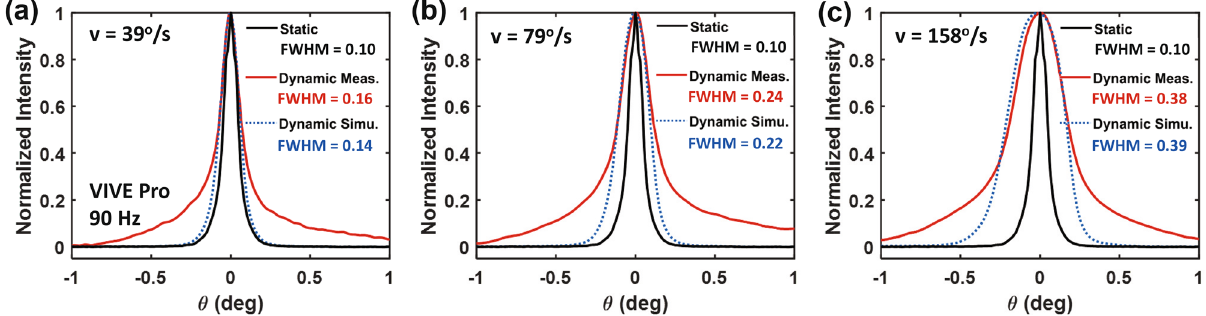
Figure 7. Measured and simulated static and dynamic LSFs for the VIVE Pro at 90 Hz with target motion velocity of 39 ( a ), 79 ( b ) and 158°/s ( c ) during smooth